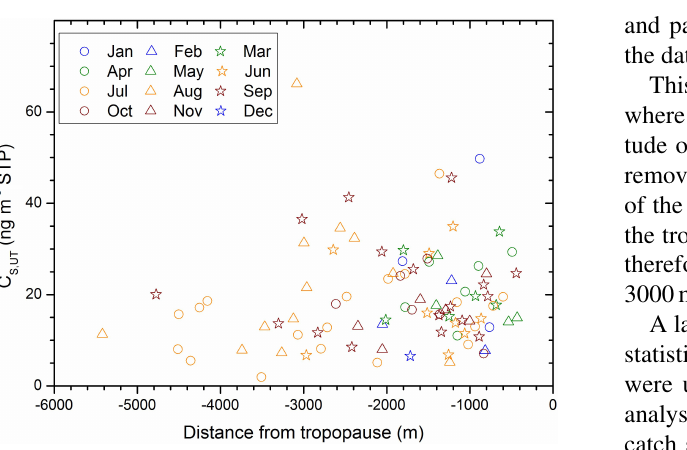
Figure 1. Upper tropospheric particulate sulfur concentration re- lated to distance from the tropopause, where the symbols indicate sampling